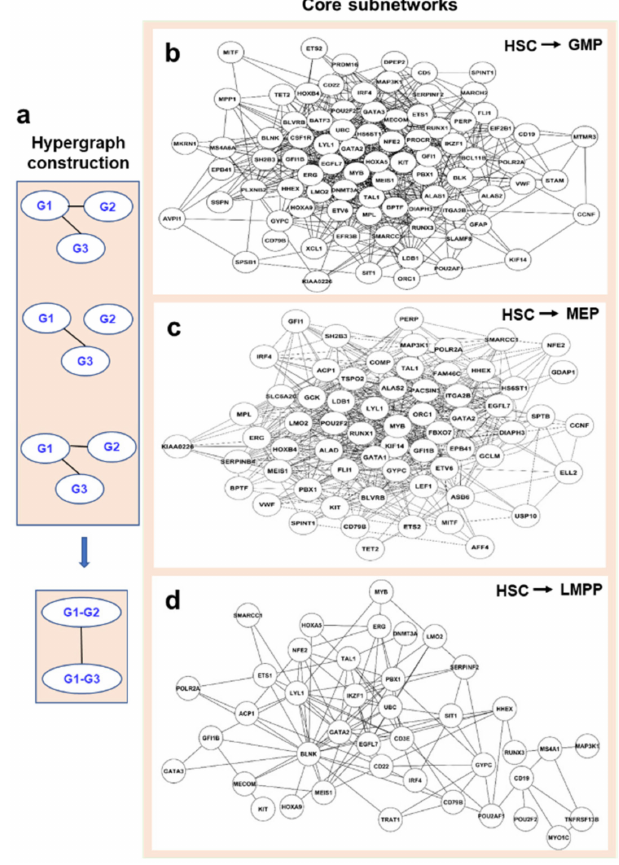
Figure 6. ( a ) A schematic diagram of hypergraph construction. Two nodes were corresponding to two original edges of G1–G3 and G1–G2. G2–G3 did not exist because G2 and G3 did not interact in original networks. The edge number attributes of G1–G3 and G1–G2 are 3 and 2, which will be used as input of BioNet. Core subnetworks expressed from HSC to MEP ( b ), to GMP ( c ), and to LMPP ( d ) progenitors identified by the edge-based scoring